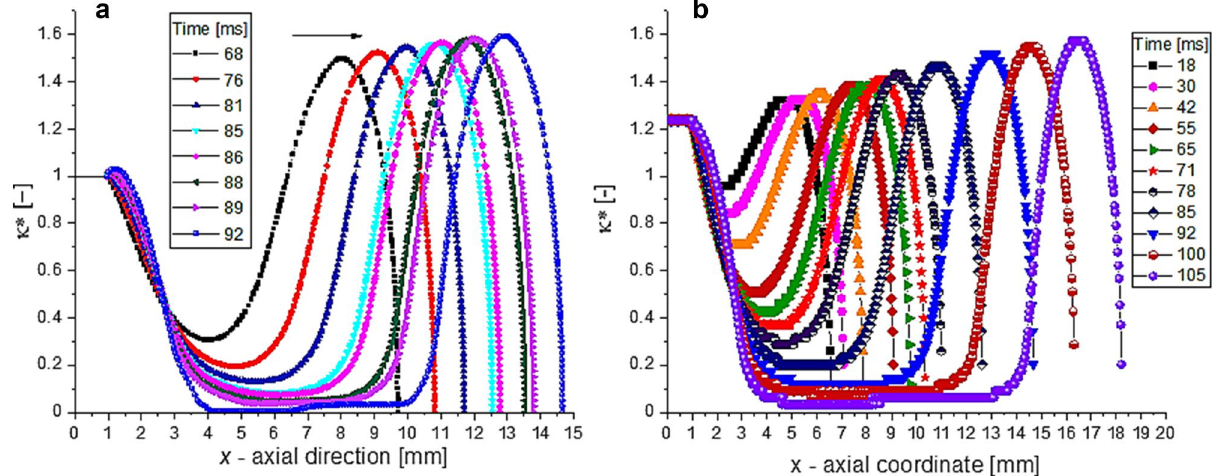
Figure 3. The contours of the droplet at different times, before the detachment from the needle: ( a ) numerical solutions at VF = 0.5, ( b ) experiments E2, Fig.